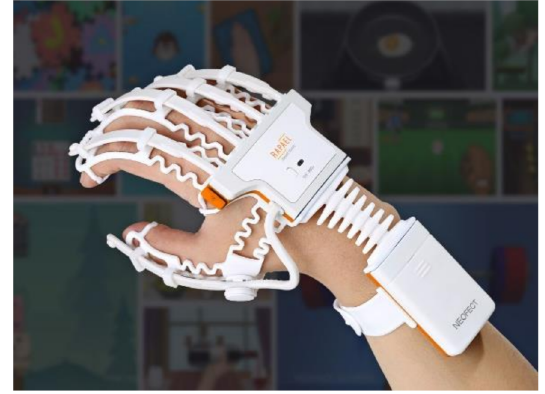
Figure 28. Neofect’s Rapael smart glove [93].